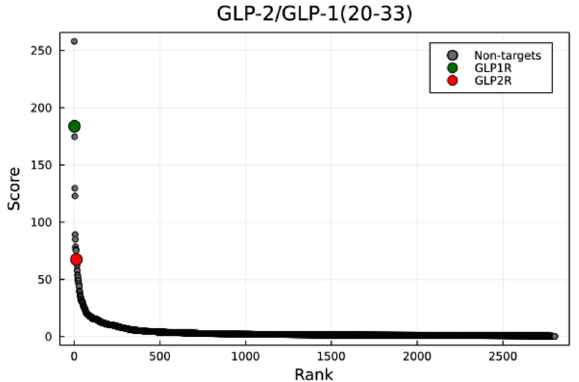
Figure 9. One-to-all curve of a chimeric peptide with roughly equal affinity for GLP1R and GLP2R. The one- to-all curve of the chimeric peptide GLP-2/GLP-1(20-33) generated with SPRINT